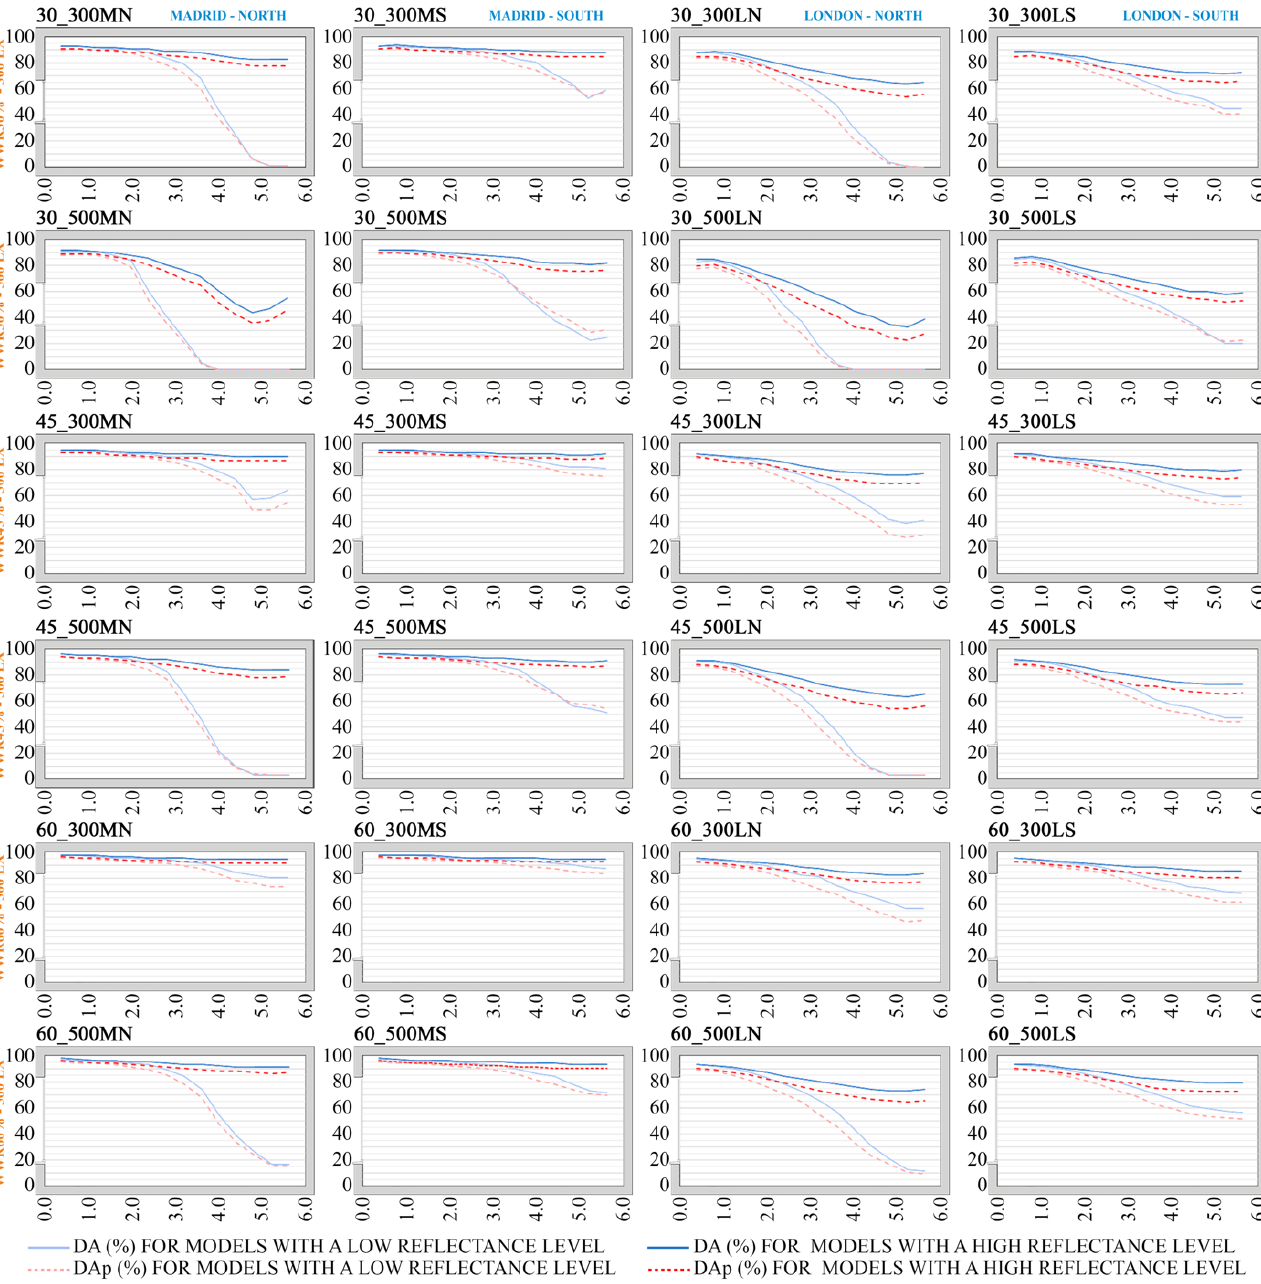
Figure 6. Quantification of DA and DAp in the calculation models according to room reflectance.